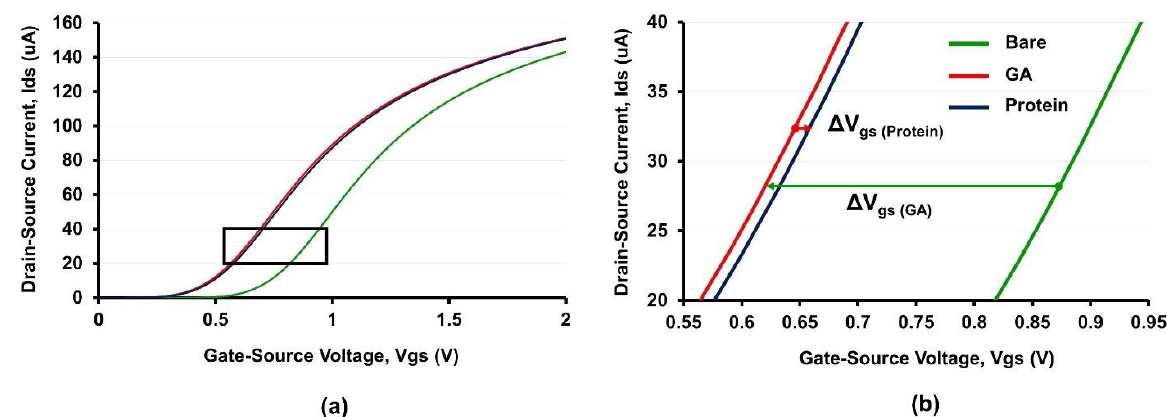
Figure 4. I ds -V gs curves after surface functionalization, protein immobilization, and antibody binding. ( a ) Measured gate potential changes against various Ids. ( b ) The extraction of gate potential changes from the linear region of I ds - V gs curves .